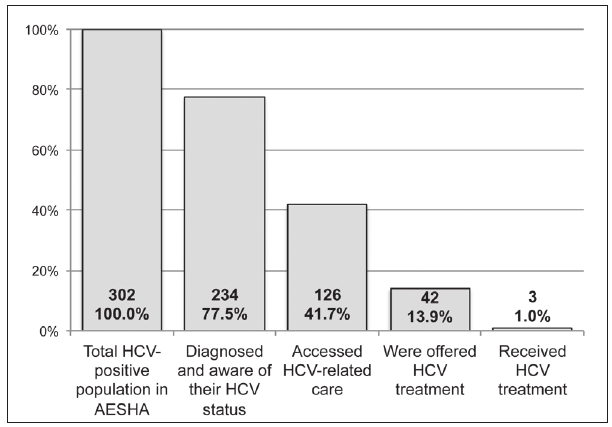
Figure 1) Hepatitis C virus (HCV) continuum of care for women sex workers living with HCV, Vancouver, British Columbia (n=302).